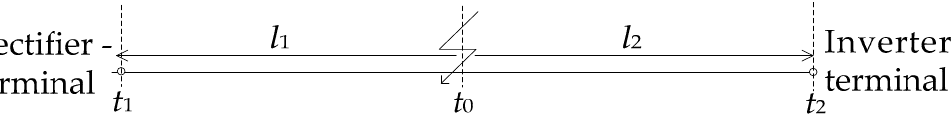
Figure 2. Propagation of the fault components.